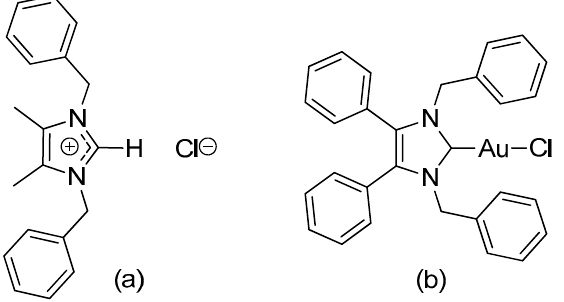
Figure 1. Structure of lepidiline A (1,3-dibenzyl-4,5-dimethylimidazolum chloride) ( a ) and NHC*-Au(I)-Cl ( 1 ) ( b ).